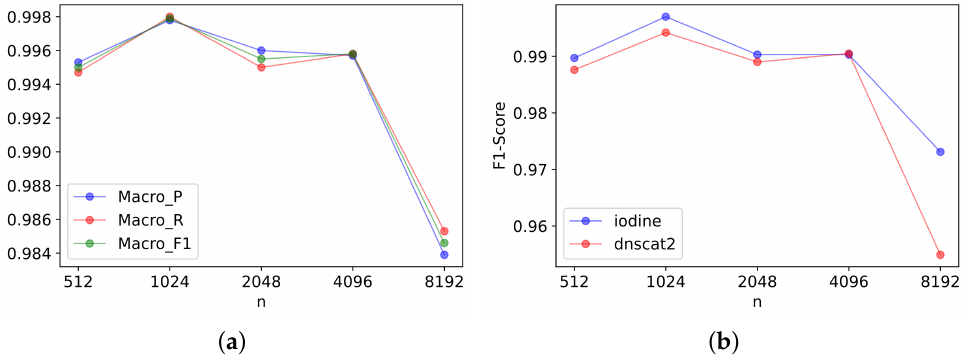
Figure 15. Comparison of results under different bytes size n : ( a ) comparison of macro-averaging under different bytes size n ; ( b ) Comparison of F1-Score under different bytes size n in identification of iodine and